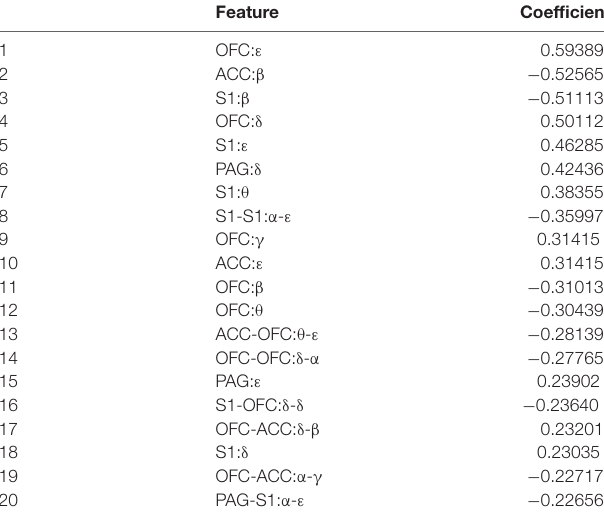
TABLE 1 | Top 20 most pain-contributing features in generalized linear model